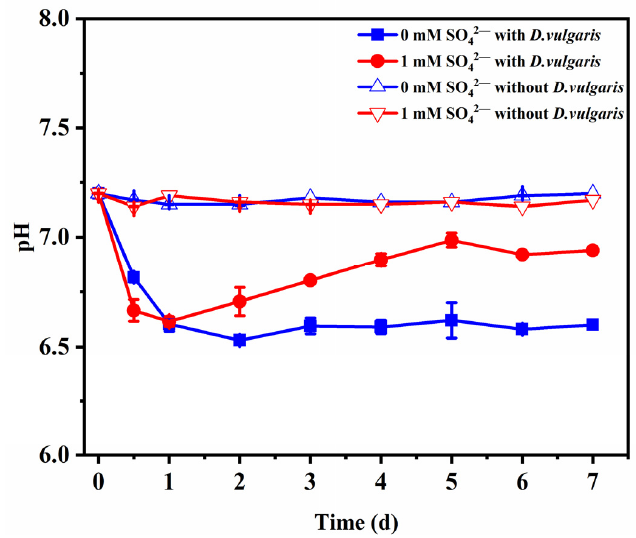
Figure 1. Variation of pH value in Fe(III) reduction experiment. Error bars indicate standard deviation of triplicates.